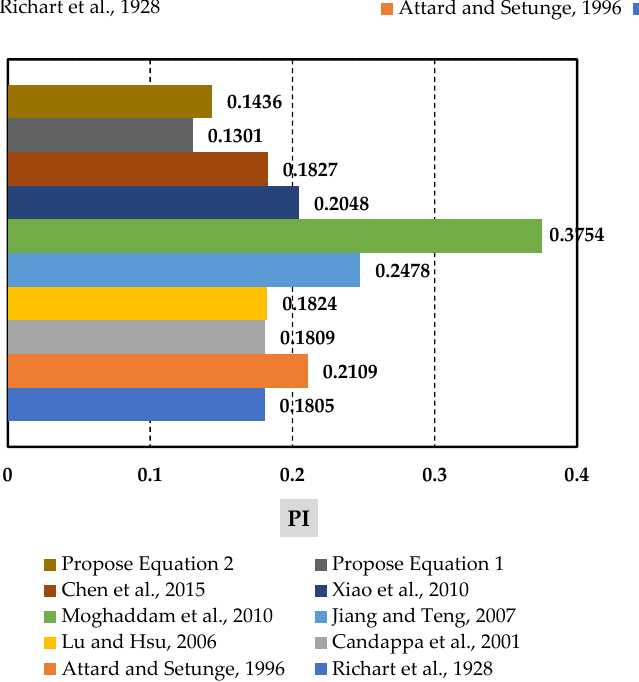
Figure 18. The diagrams of each indicator for the axial strain correspond to the peak compressive strength models presented by different researchers and the proposed models [25,26,69–74].